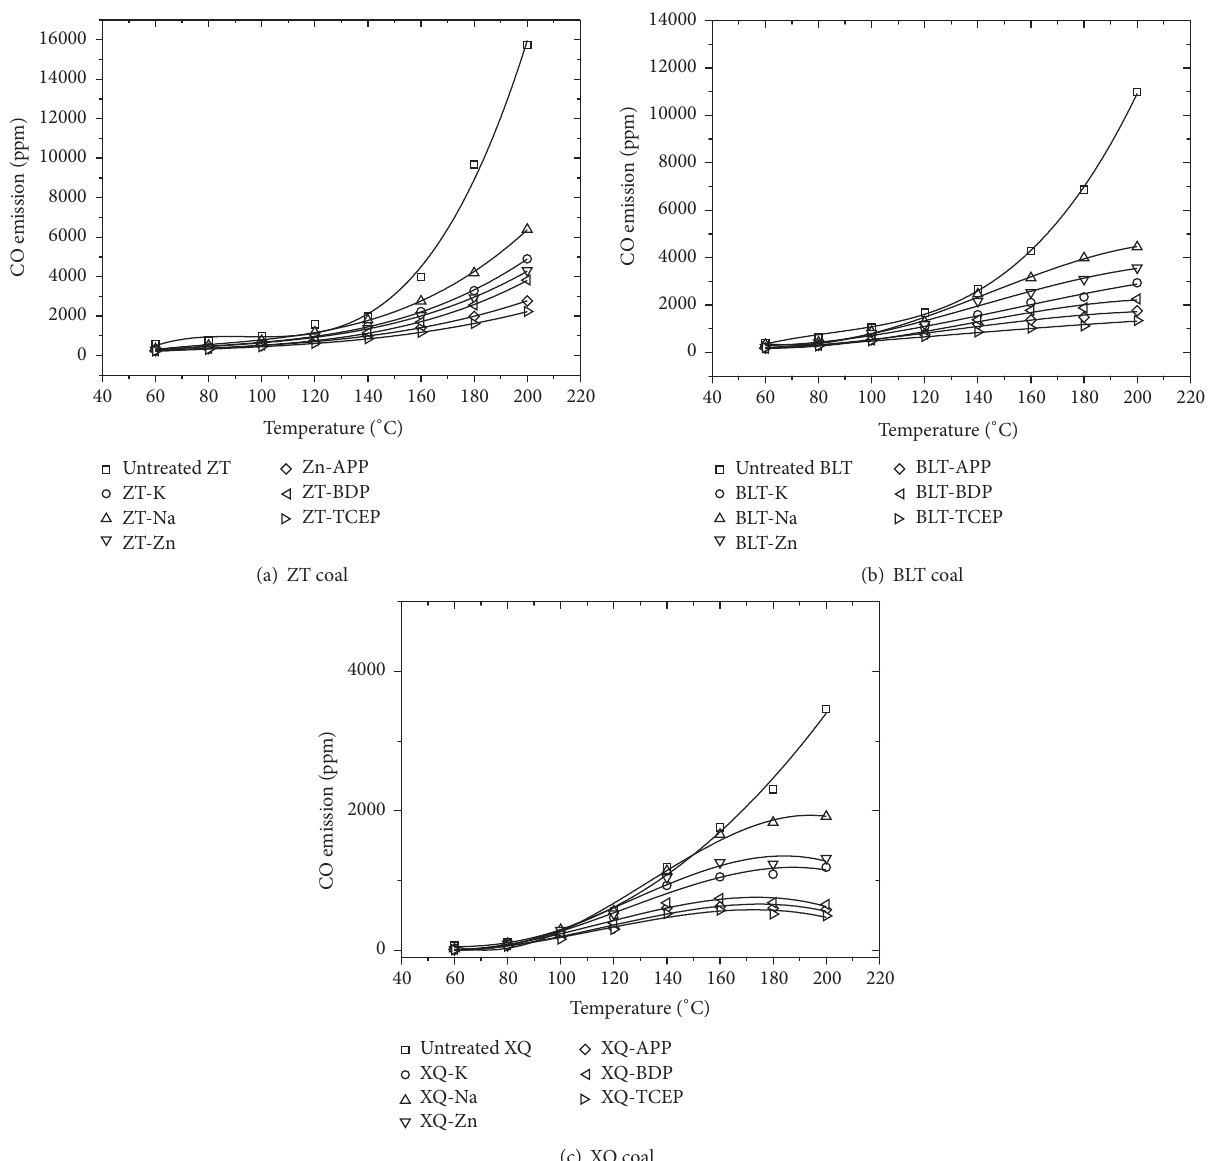
Figure 5: The CO emission of coal samples before and after